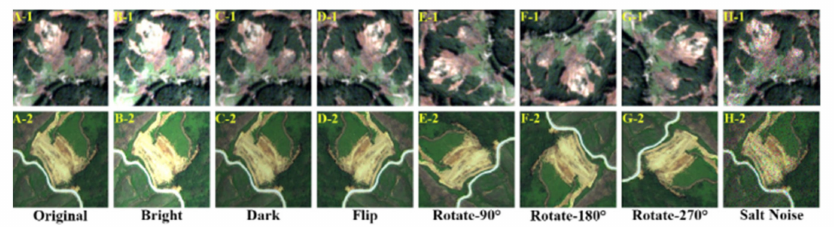
Figure 6. Data augmentation. *-1 represents the Iburi dataset, *-2 represents the Bijie dataset. All converts are implemented through OpenCV. * represents